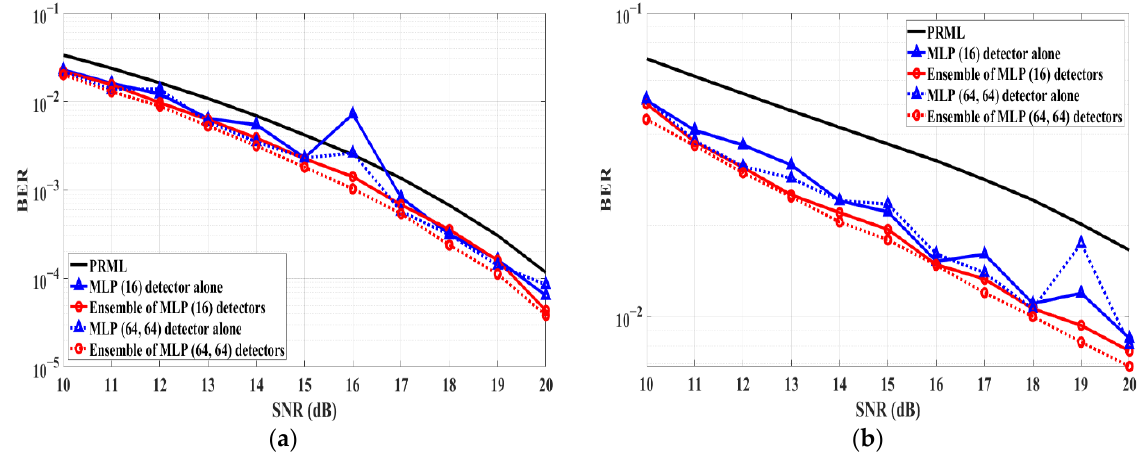
Figure 4. BER performance comparison of the models: ( a ) TMR of 0%; ( b ) TMR of 30%.